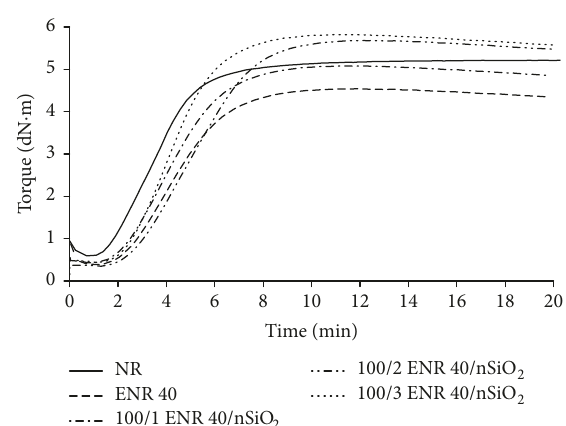
Figure 4: MDR rheographs of NR, ENR 40, and ENR 40/nSiO 2 nanocomposites.